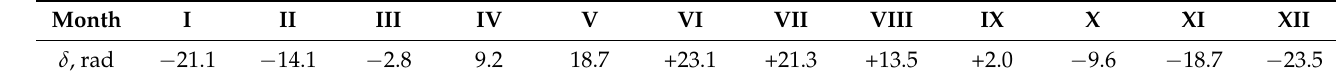
Table 1. Average monthly solar